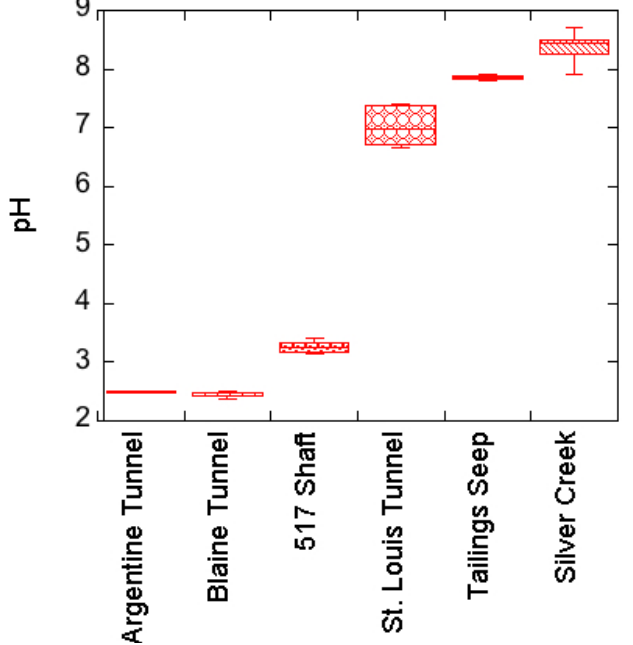
Figure 2. Box plot of pH in the mine workings along with that of the St. Louis Tunnel portal and tailings seep discharges and of surface waters in Silver